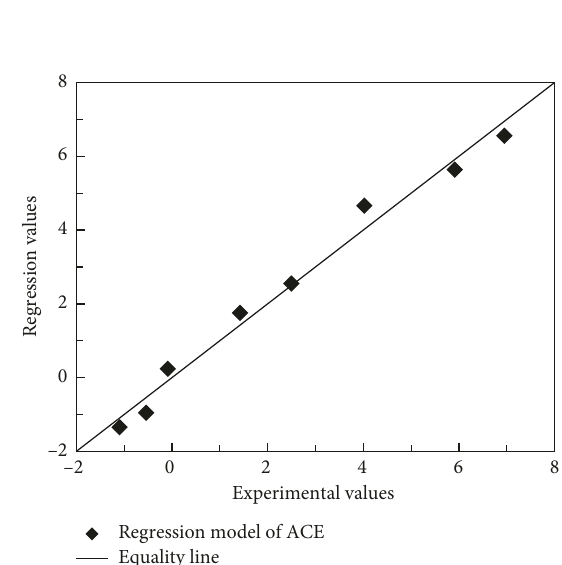
Figure 8: Comparison of the experimental and regression values for y